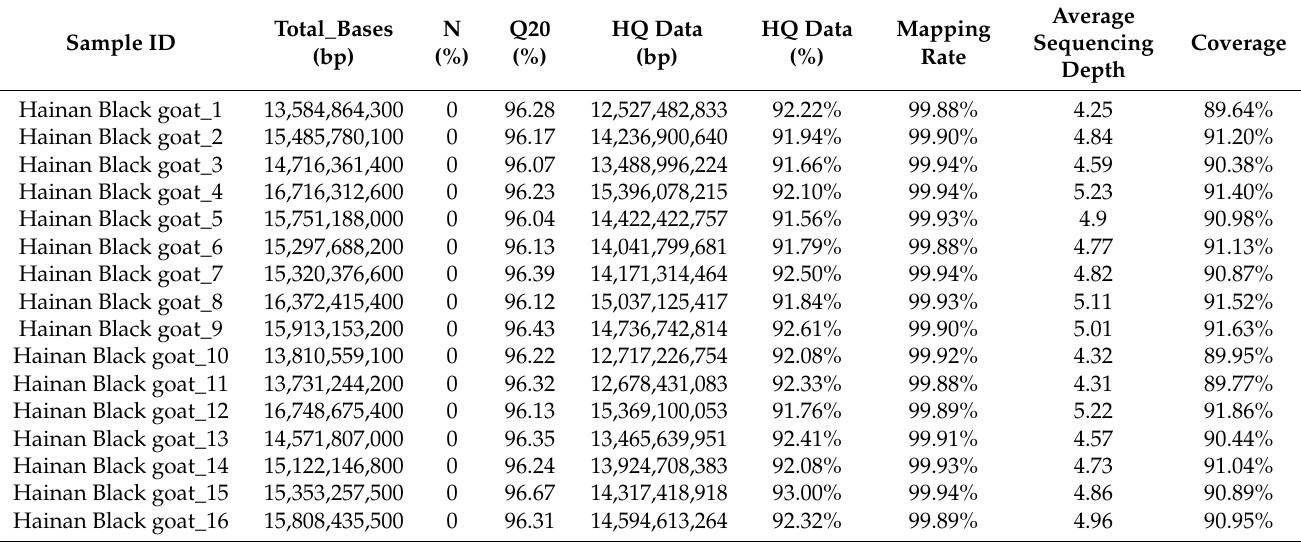
Table A1. Sequencing data information for 16 Hainan Black